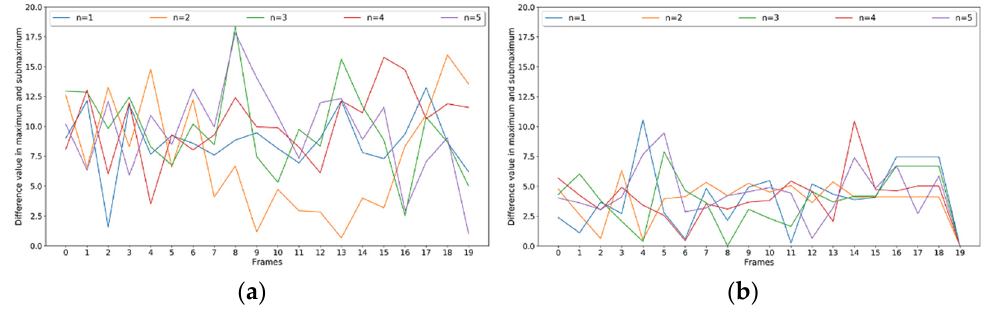
Figure 5. Difference of each frame in Lingvo by five normal speech ( a ) and C&W adversarial examples ( b ).